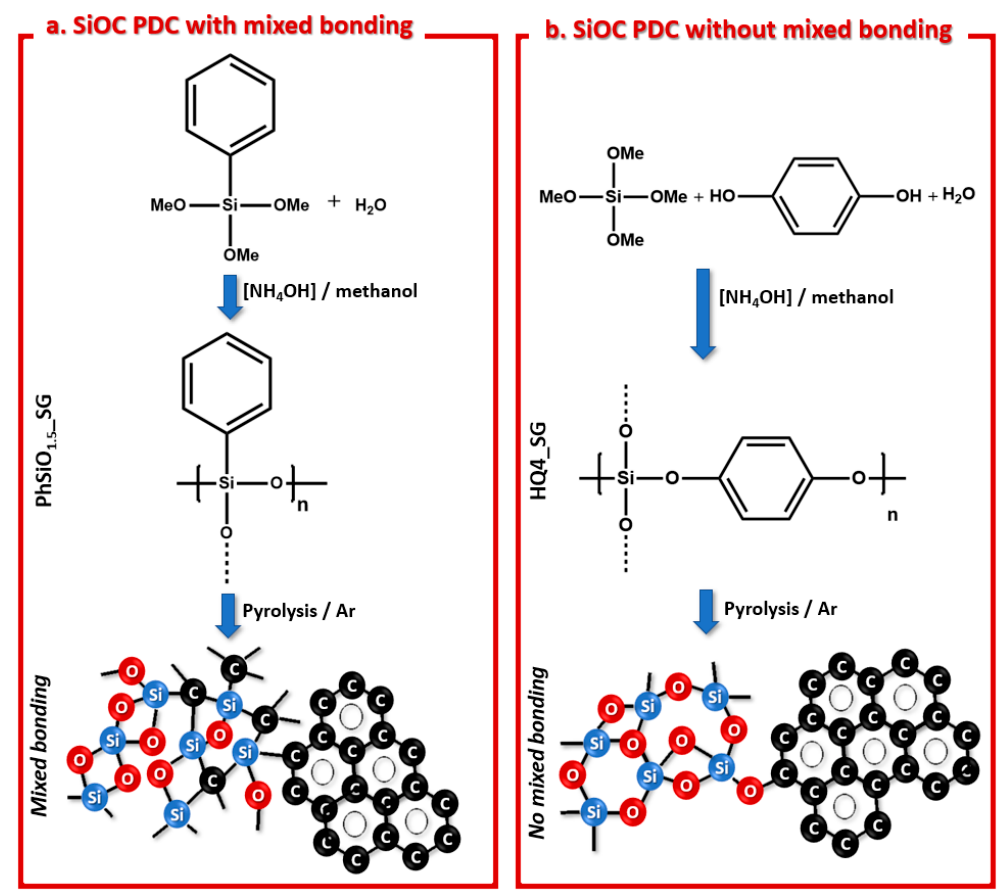
Figure 1. ( a ) Synthesis of PhSiO 1.5 _SG using trimethoxyphenylsilane (TMOPS) precursor to synthesize a polymer with the phenyl group bonding directly to silicon resulting in a SiOC PDC with mixed bonding. ( b ) Synthesis of HQ4_SG using hydroquinine (HQ) and tetramethylorthosilicate (TMOS) precursors to synthesize a polymer with the phenyl group bonding to the silicon through Si-O-C bridges resulting in a SiOC PDC without mixed bonding. Table 1. Analyzed composition of SiOCH ceramic recorded as wt% (at.%).